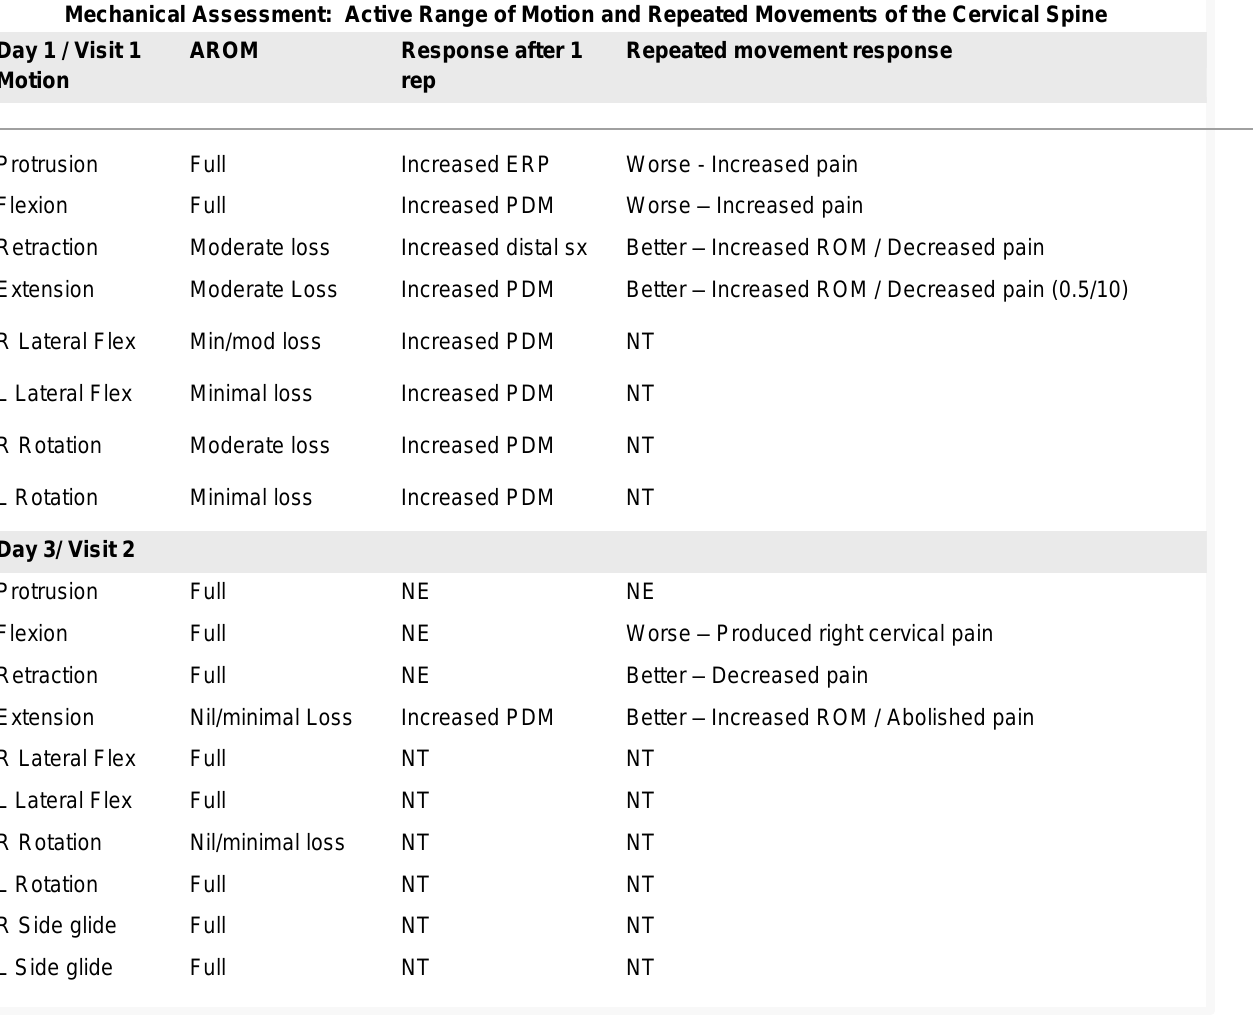
Table 5: Patient #2 - Right Cervical and Upper Trapezius Pain Mechanical Assessment: Active Range of Motion and Repeated Movements of the Cervical